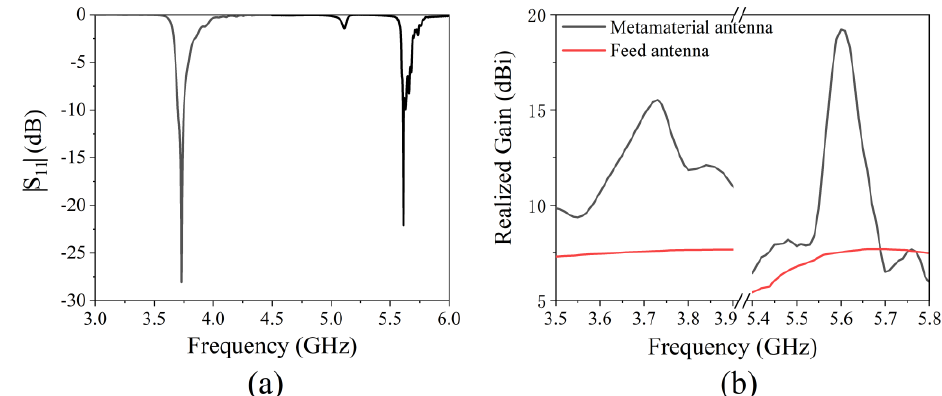
Figure 7. Simulated ( a ) return loss (|S 11 |) and ( b ) realized gain of the metamaterial antenna.